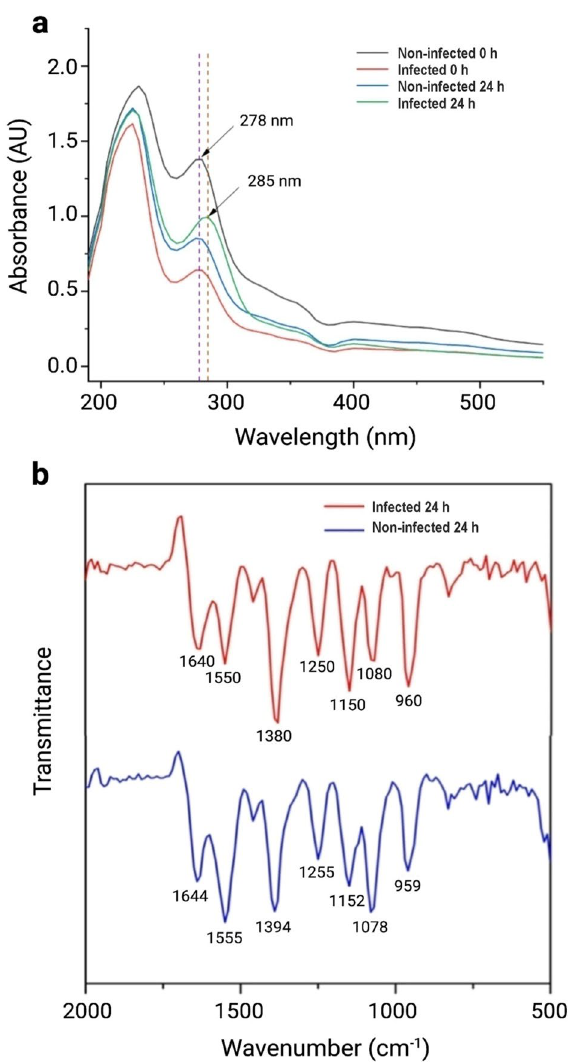
Figure 4. UV–vis spectra and FTIR analyses. ( a ) UV–vis spectra and ( b ) FTIR spectra of hemolymph from non-infected and infected